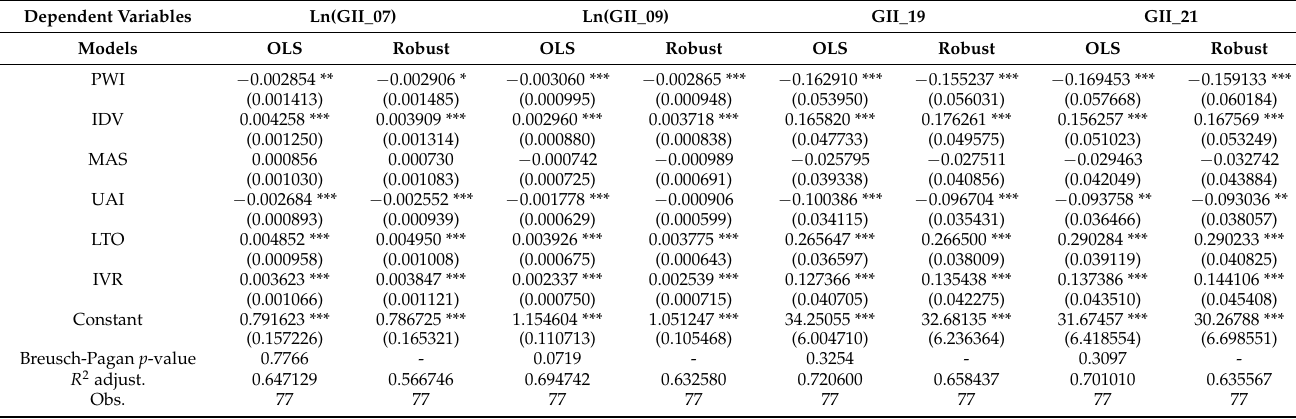
Table 5. A cross-sectional regression output (all